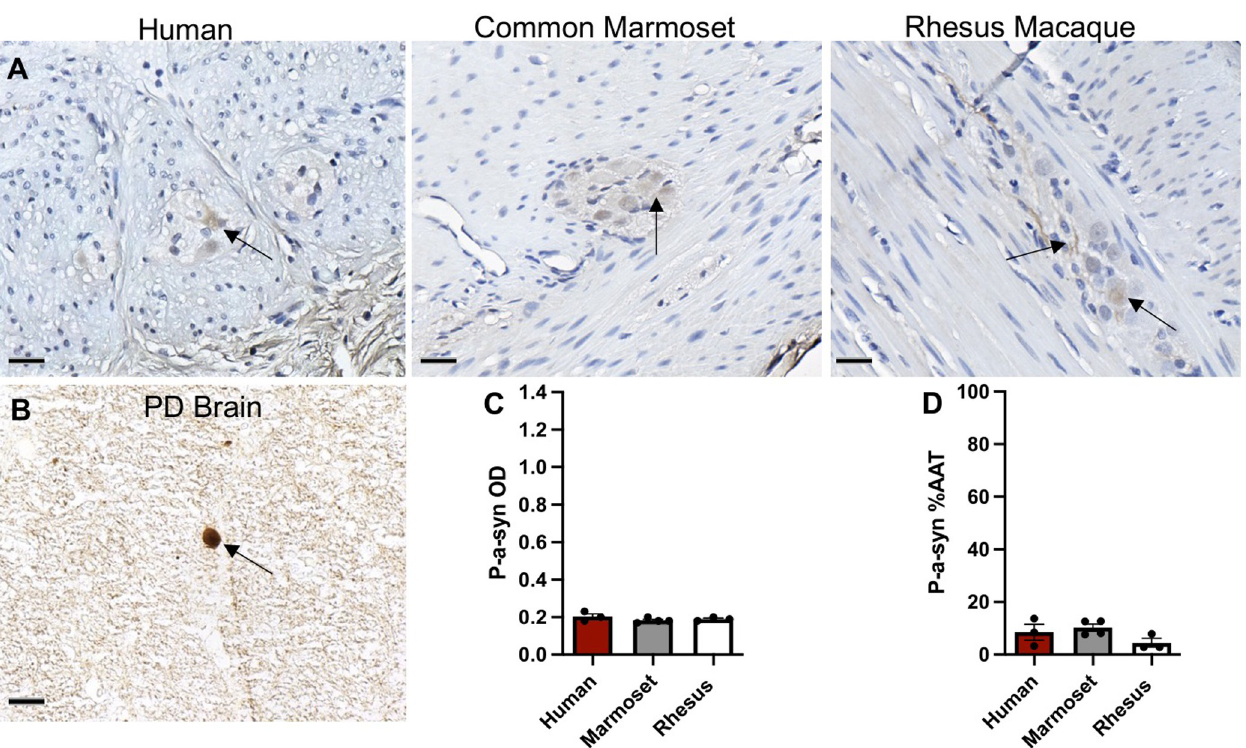
Fig 3. P- α -syn expression in the appendix/cecum across species. (A) Images of p- α -syn-immunoreactivity (-ir) (brown) in the myenteric ganglia (arrows) in human appendix, common marmoset and rhesus macaque ceca tissue sections counterstained with hematoxylin (blue). (B) Image of p- α -syn-ir in a Lewy body from human Parkinson’s disease brain tissue section. Graphs (mean ± SEM) of p- α -syn-ir (C, D) in muscularis externa ganglia across species. Scale bar; 25 μ m. Abbreviations: %AAT, percent area above threshold; OD, optical density; PD, Parkinson’s disease. p- α -syn, serine 129 phosphorylated alpha-synuclein.